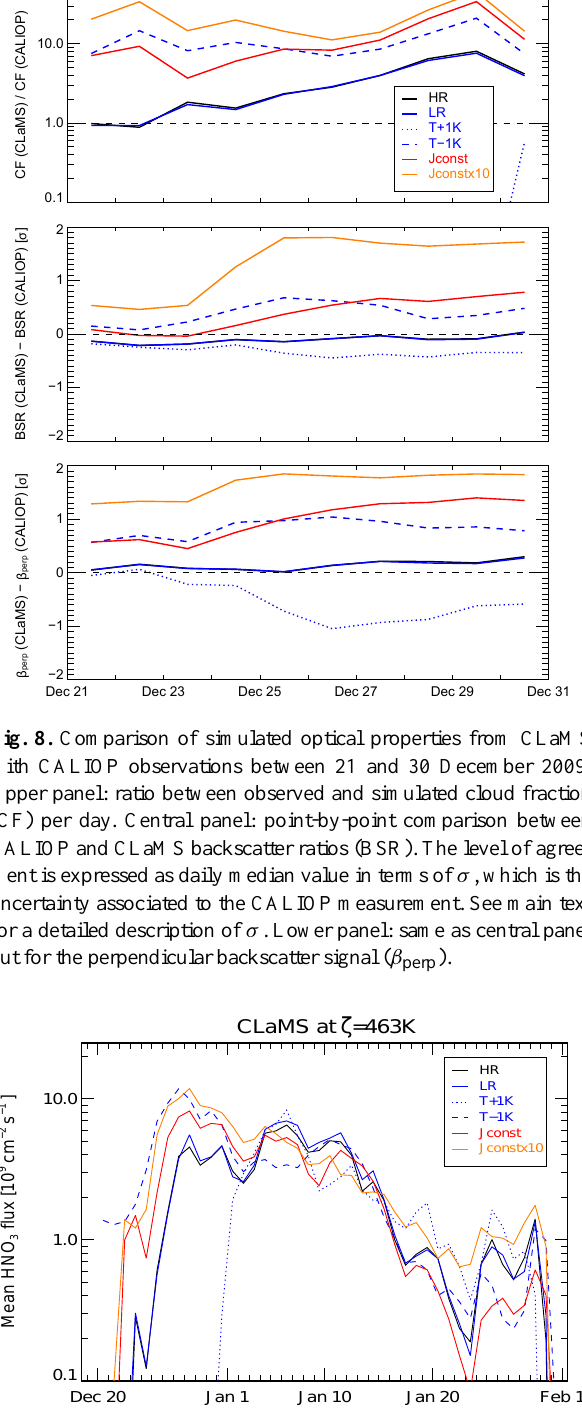
Fig. 9. Calculated mean HNO 3 flux within the model level at 463K for the cold period between late December and end of January. Shown are the results for the different sensitivity simulations in- dicated by the line colours and styles as in Fig. 8